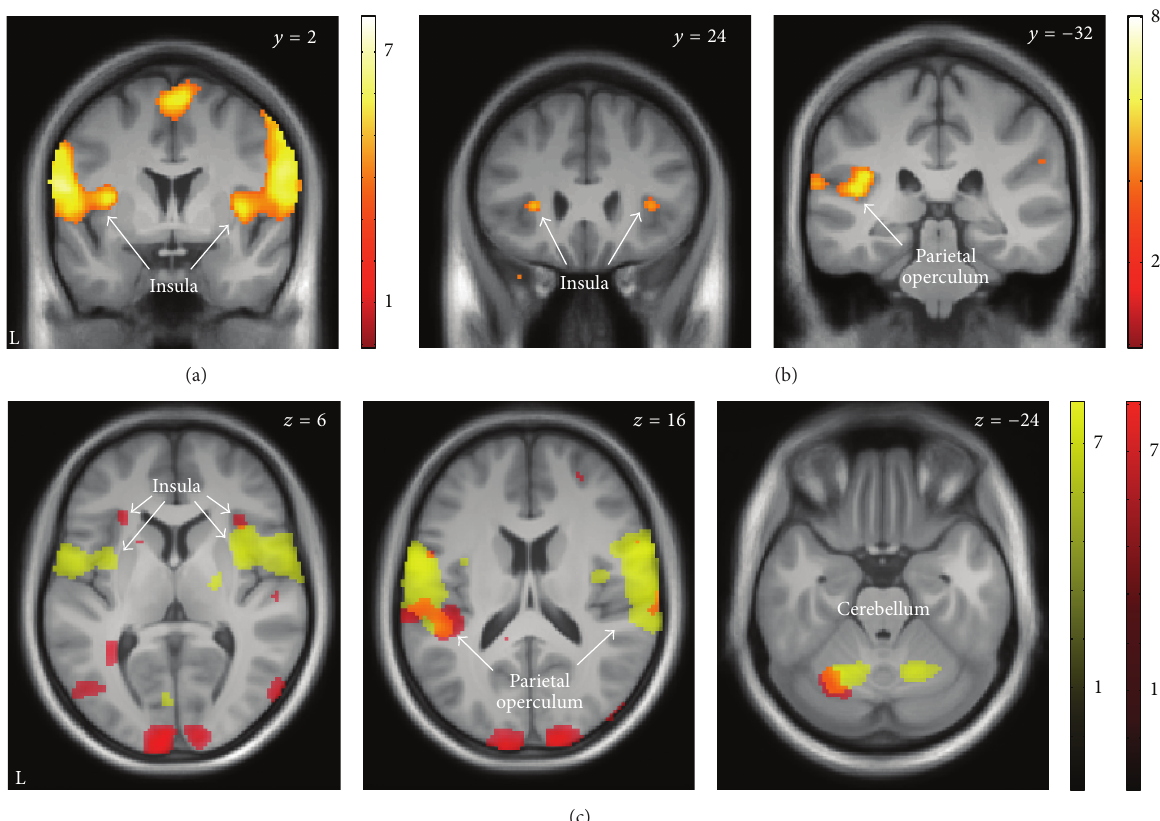
Figure 3: Perception (a) and anticipation (b) of severe versus mild dyspnea activated insular, parietal opercular, and cerebellar cortex. (c) Activation during anticipation (displayed in red) and perception of dyspnea (displayed in yellow) overlapped in the left cerebellum and parietal operculum while insular activation was more anterior during anticipation as compared to perception of dyspnea. Activation patterns are displayed at a threshold of 𝑝 < 0.05 , corrected for the specific ROI, and superimposed on the group-specific T1-weighted mean image generated by the DARTEL-protocol. L =